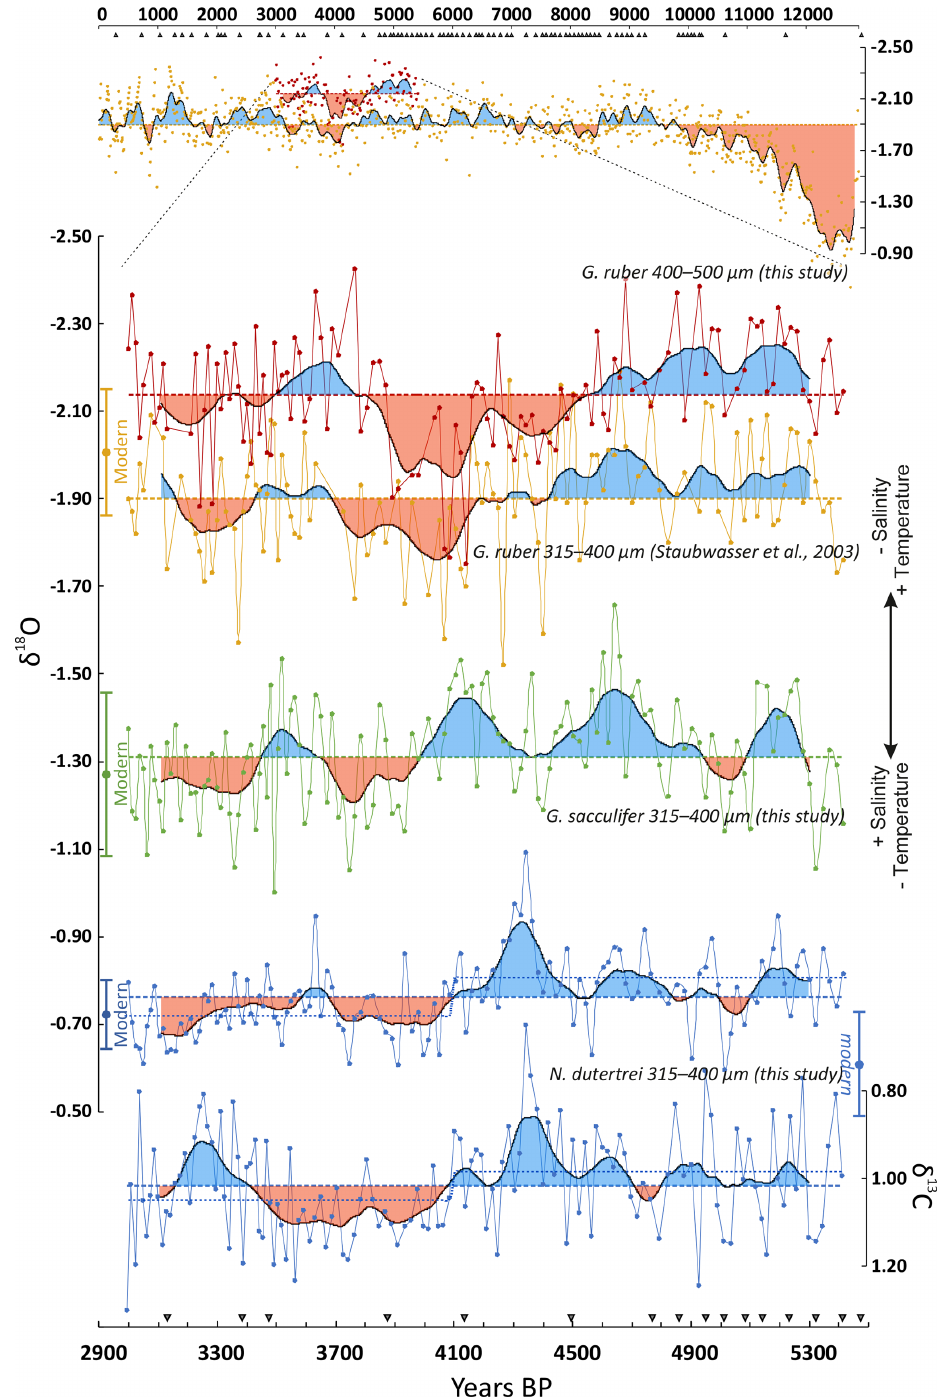
Figure 3. Core 63KA δ 18 O G. ruber from two size fractions shown in the context of the original record and also zoomed in over 5.4–3.0ka: 400–500µm (red) (this study), 315–400µm (orange) (Staubwasser et al., 2003). δ 18 O of G. sacculifer 315–400µm (green), and δ 18 O and δ 13 C of N. dutertrei 315–400µm (blue) are shown over the interval 5.4–3.0ka. Data are shown with a 210-year loess smoothing, and modern surface values ± 1 σ are plotted for comparison. Mean values for all species are denoted by the dotted line, and the pre- and post-4.1ka mean values are indicated by an additional dotted line for N. dutertrei . Individual AMS radiocarbon dates are denoted by triangles near the